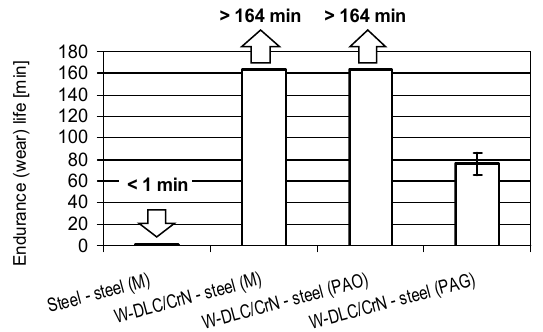
Figure 4. Endurance (wear) lives obtained in abrasion tests.